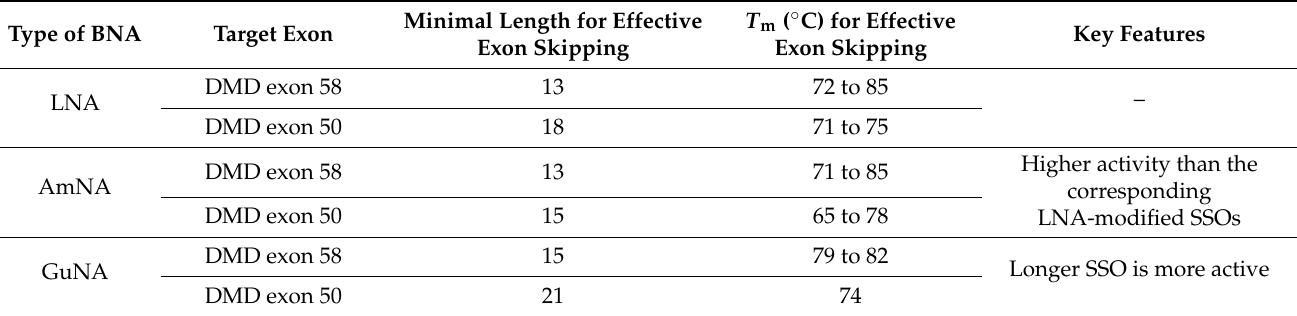
Table 1. Summary of BNA-modified SSOs in this